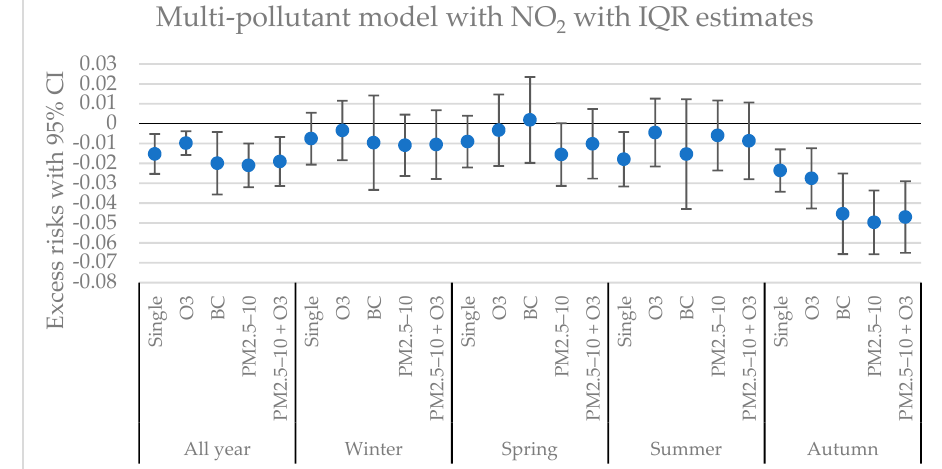
Figure 5. Estimated excess risks in daily mortality with 95% CI (lag 02) for an IQR increase in the concentrations of NO 2 . The calculations are divided into all year and four different seasons. The excess risks are presented as single ‐ pollutant estimates and multi ‐ pollutant estimates with O 3 , BC, PM 2.5–10 and PM 2.5–10 + O 3 included in the calculations.